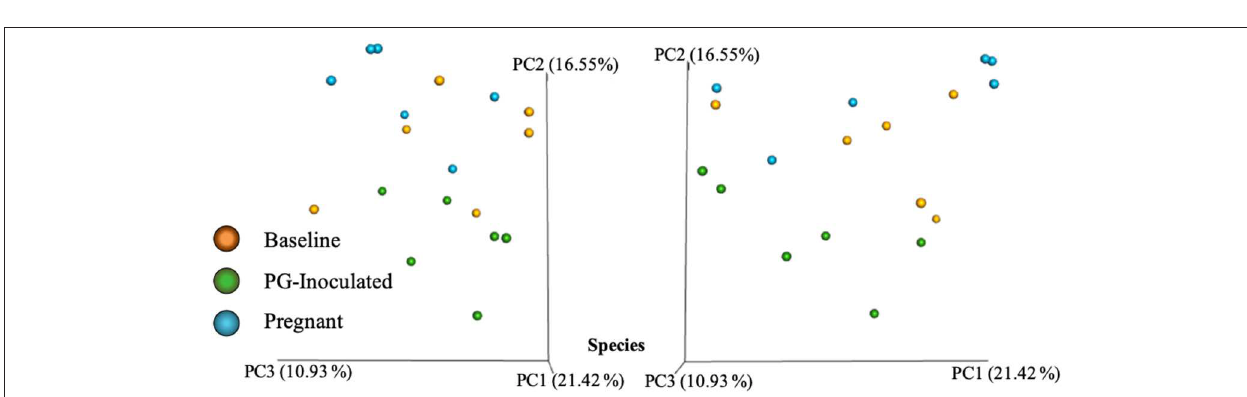
FIGURE 4 | Bray Curtis PCoA plot of beta diversity measures of dissimilarity shows at the species level, baseline, PG-inoculated, and pregnant groups clearly clustered within their group along PC2 not PC1.